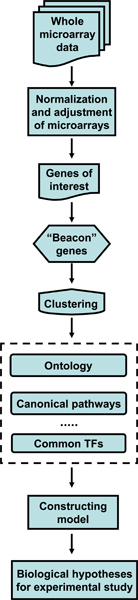
Schematic diagram of steps in microarray analysis.